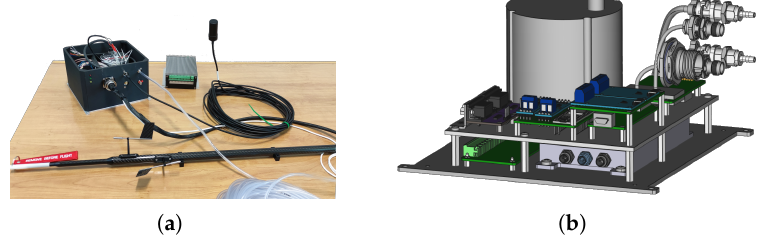
Figure 1. ASSE demonstrator design. ( a ) A view of the ASSE technological demonstrator developed under the SAIFE project, ( b ) Arrangement design. Courtesy of SELT Aerospace &